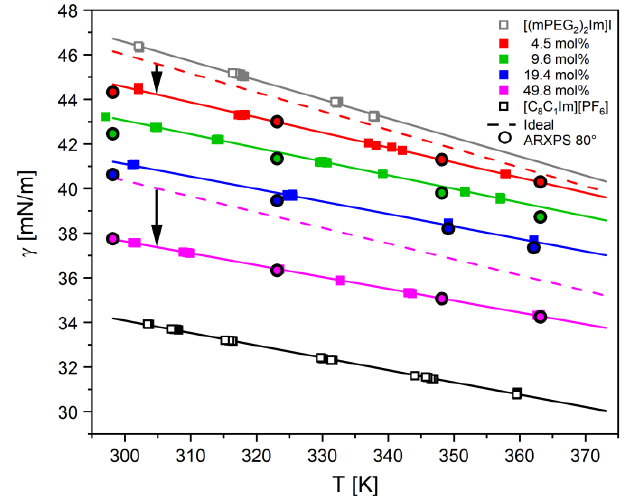
Figure 5. Surface tension values measured using the PD method are shown as open and full squares, along with their linear fits (lines) using Equation (1). The surface tension values calculated from the 80° ARXPS data using Equation (3) are shown as filled circles. Furthermore, the ideal behaviour for the surface tension of the 4.5 and 49.8 mol% mixtures as determined by Equation (2) (dashed lines) is included for comparison (a comparison for all mixtures is shown in Figure S4).